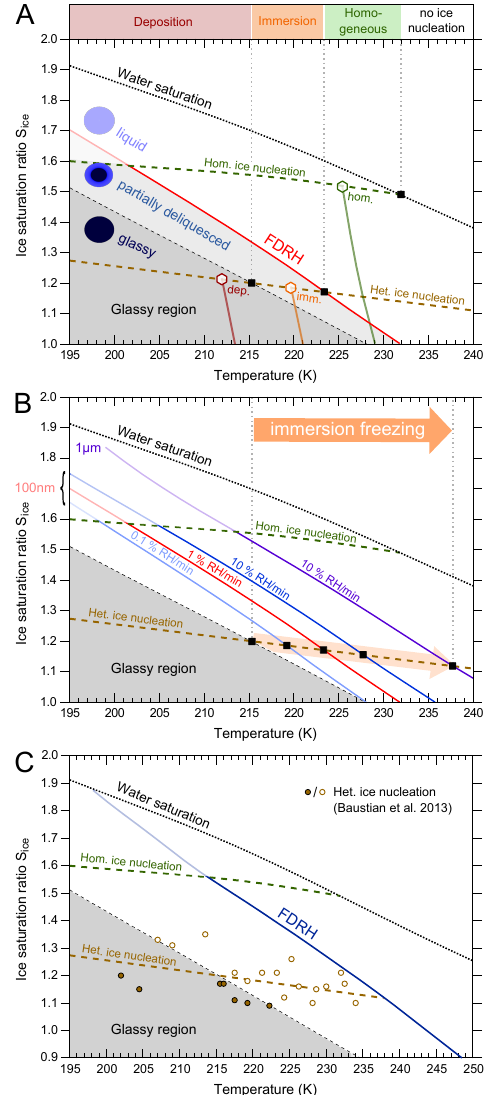
Figure 2. (a) Simulated regimes of heterogeneous and homoge- neous ice nucleation in the humidification of sucrose particles. The red solid line indicates full deliquescence relative humidities (FDRH) for 100nm particles exposed to a humidification rate of 1% RH min − 1 ( ≈ 0.2ms − 1 atmospheric updraft). Example trajec- tories start at ice saturation, follow a constant dew point line and end at expected ice nucleation (hexagonal markers) with deposi- tion (red), immersion (orange), and homogeneous (green) freezing. (b) Effects of different particles sizes and humidification rates on FDRH. The upper boundary for immersion freezing is extended to high temperatures for large particle radii and high humidification rates and is expected to occur up to 238K for the most extreme sce- nario (1µm, 10% RHmin − 1 , purple solid line). (c) Application to the experimental conditions in Baustian et al. (2013), i.e. 4µm par- ticles humidified at a rate of 1% RH min − 1 , leads to FDRH that is able to explain all observed experimental ice onsets (brown cir- cles). The thermodynamic glass transition divides the experimental data in events of deposition ice nucleation (closed circles) and im- mersion freezing (open circles). Atmos. Chem. Phys., 14, 12513–12531,